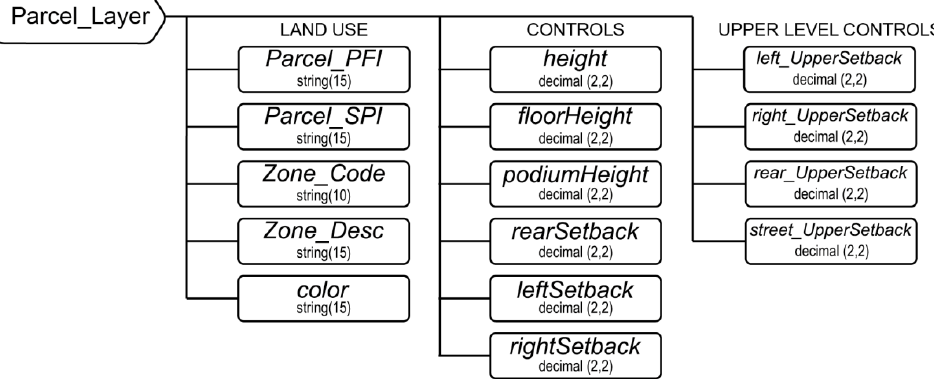
Figure 3. Proposed Parcel_Layer structure.